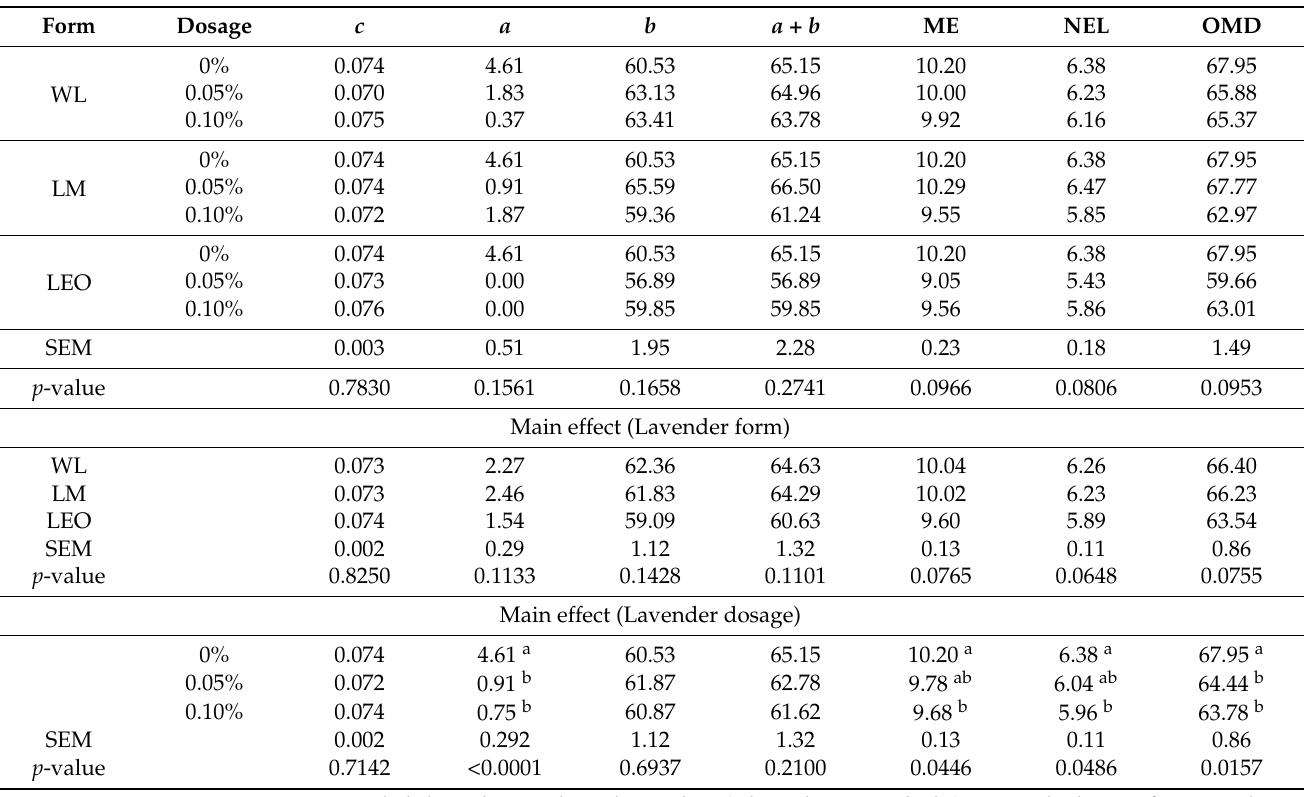
Table 4. The effects of different doses and forms of lavender on gas kinetics, in vitro degradability, and estimated energy